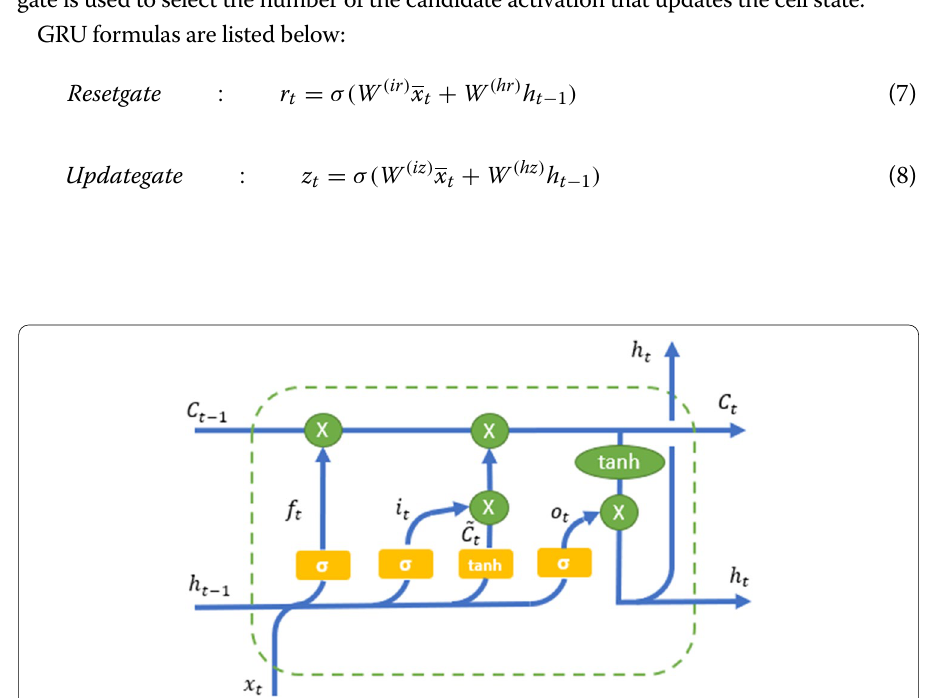
Fig. 1 Architecture of the LSTM